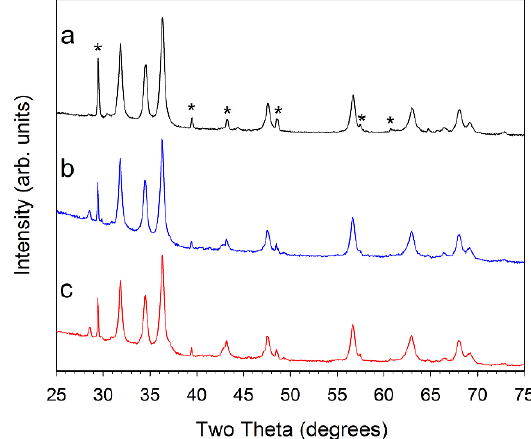
Figure 4. Powder XRD results for ( a , black) 1% Ni–ZnO; ( b , blue) 5% Ni–ZnO; and ( c , red) 10% Ni–ZnO. The major peaks for CaCO 3 are marked with a * symbol in ( a ). The small peak near 28.5 ◦ is consistent with KCl.